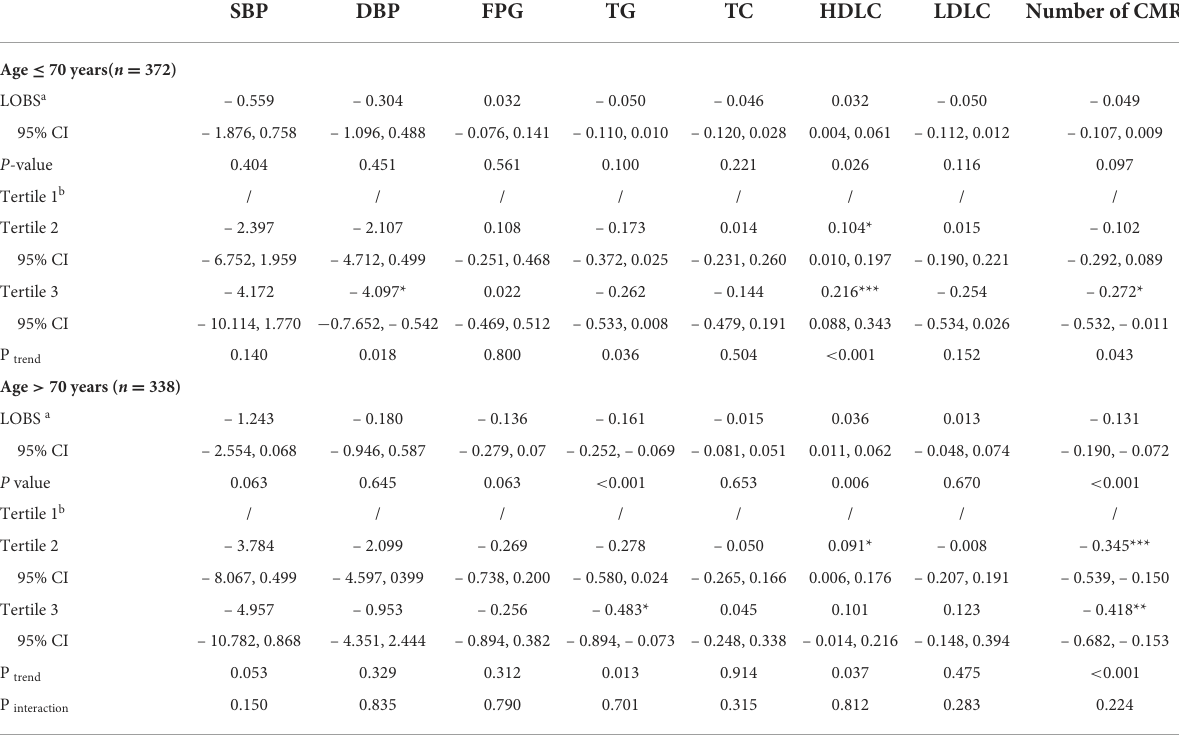
TABLE 4-1 Associations of the lifestyle-based oxidative balance score with the number of cardiometabolic risk factors and cardiometabolic biomarkers by age using linear